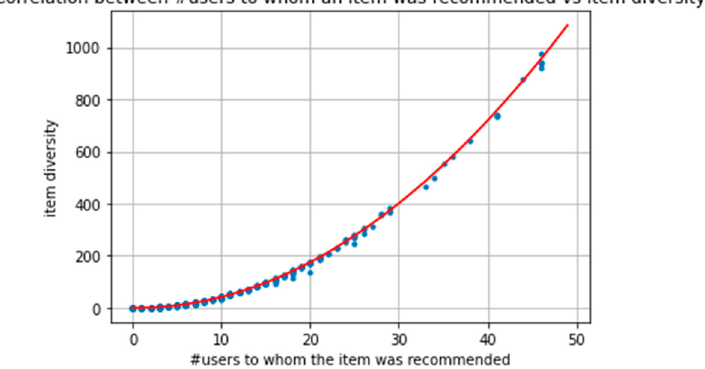
Figure 6. Relation between item diversity and number of users to whom the items were recommended (outliers removed).